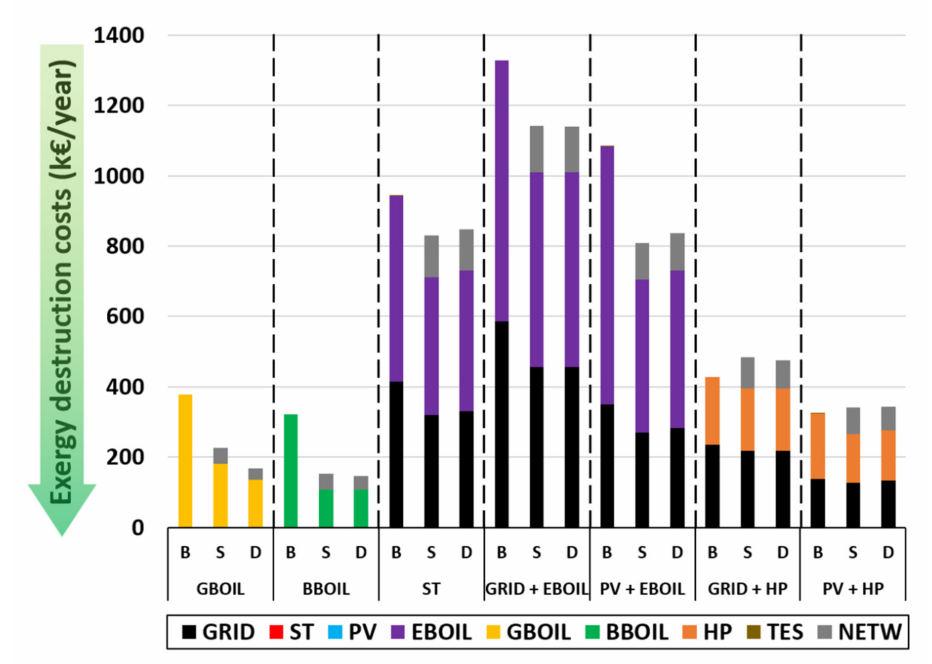
Figure 7. Exergy destruction costs, overall and unit by unit, for each solution at each